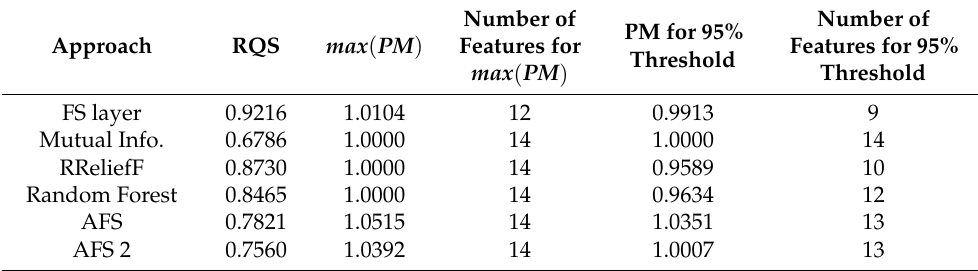
Table 12. Task performance and ranking quality for C-MAPSS FD001 dataset.